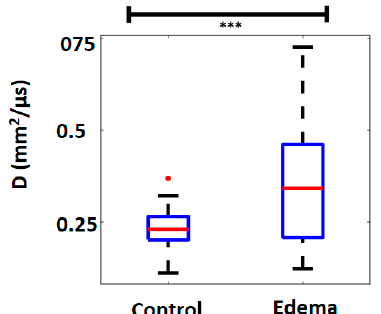
Figure 8. The D values are significantly higher in the edematous lung than in the control lung. * : p < 0.05. ***: p < 0.005.